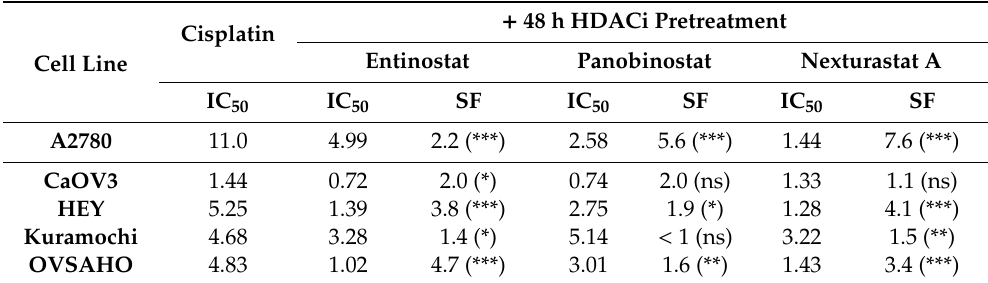
Table 6. E ff ect of HDACi pretreatment on cisplatin-induced cytotoxicity (MTT assay).